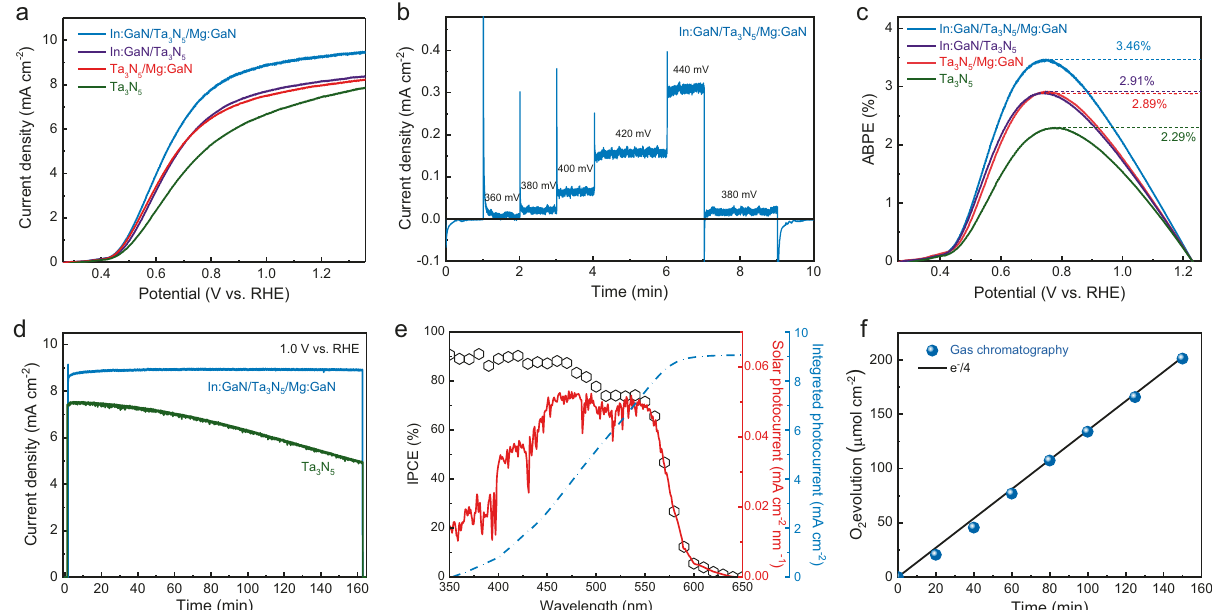
Fig. 4 PEC performance of the In:GaN/Ta 3 N 5 /Mg:GaN photoanode on Nb substrate. a J – V curves of Ta 3 N 5 -based photoanodes with different layered structures. All the photoanodes were modi fi ed with NiCoFe-B i co-catalyst and tested in 1 M KOH electrolyte under AM 1.5 G illumination. b The steady- state photocurrent of In:GaN/Ta 3 N 5 /Mg:GaN photoanode under low-bias conditions. c ABPE curves calculated from the J-V curves in a . d Stability of the pristine Ta 3 N 5 and In:GaN/Ta 3 N 5 /Mg:GaN photoanodes measured at an applied potential of 1.0 V vs. RHE. e IPCE spectrum of the In:GaN/Ta 3 N 5 /Mg:GaN photoanode at 1.0 V vs. RHE and the corresponding solar photocurrent and integrated photocurrent calculated using the standard AM 1.5 G solar spectrum (ASTM G173-03). f Amount of O 2 evolved from the In:GaN/Ta 3 N 5 /Mg:GaN photoanode under an applied potential of 1.0 V vs. Ta 3 N 5 /Mg:GaN photoanode quanti fi ed by the gas chromatogra- (e − /4) calculated from the measured photocurrent (Supplemen-